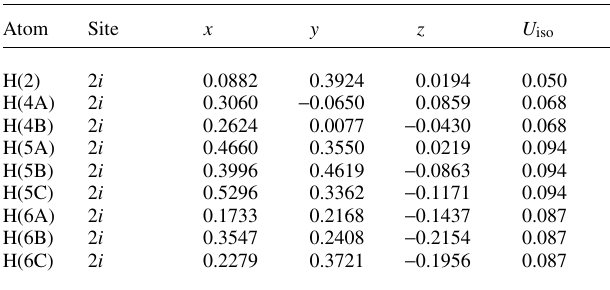
Table 2. Atomic coordinates and displacement parameters (in Å 2 )